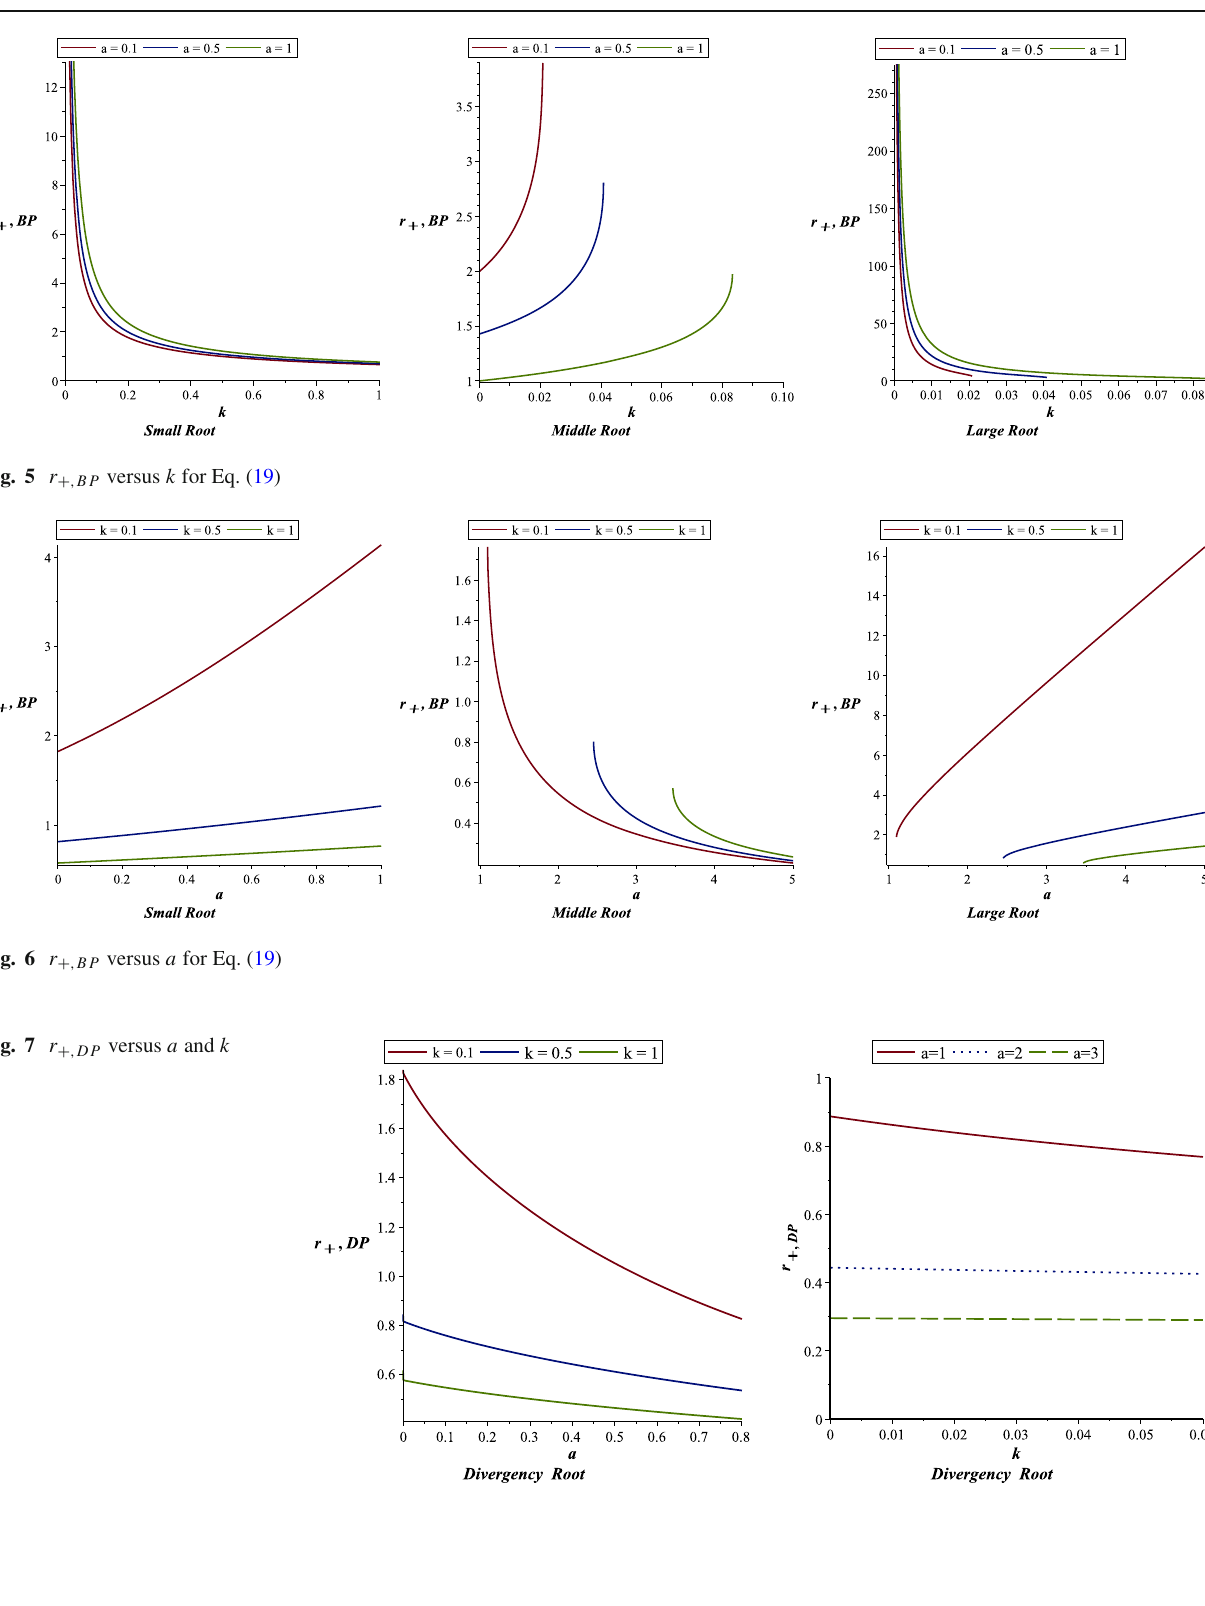
Fig. 5 r + , BP versus k for Eq. (19)